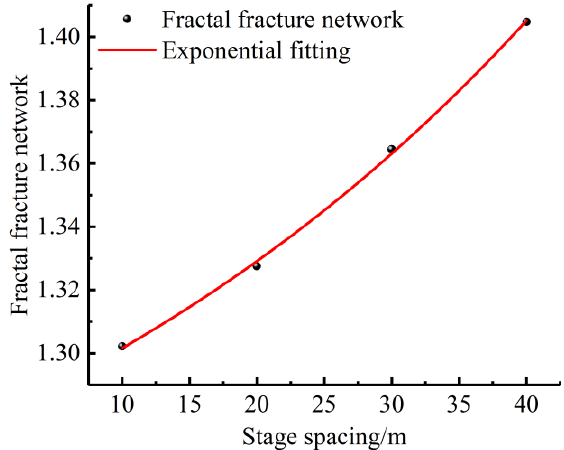
Figure 25. Variation curve of the fractal dimension of segmental hydraulic fractures in CBM reservoirs with various fracturing intervals.